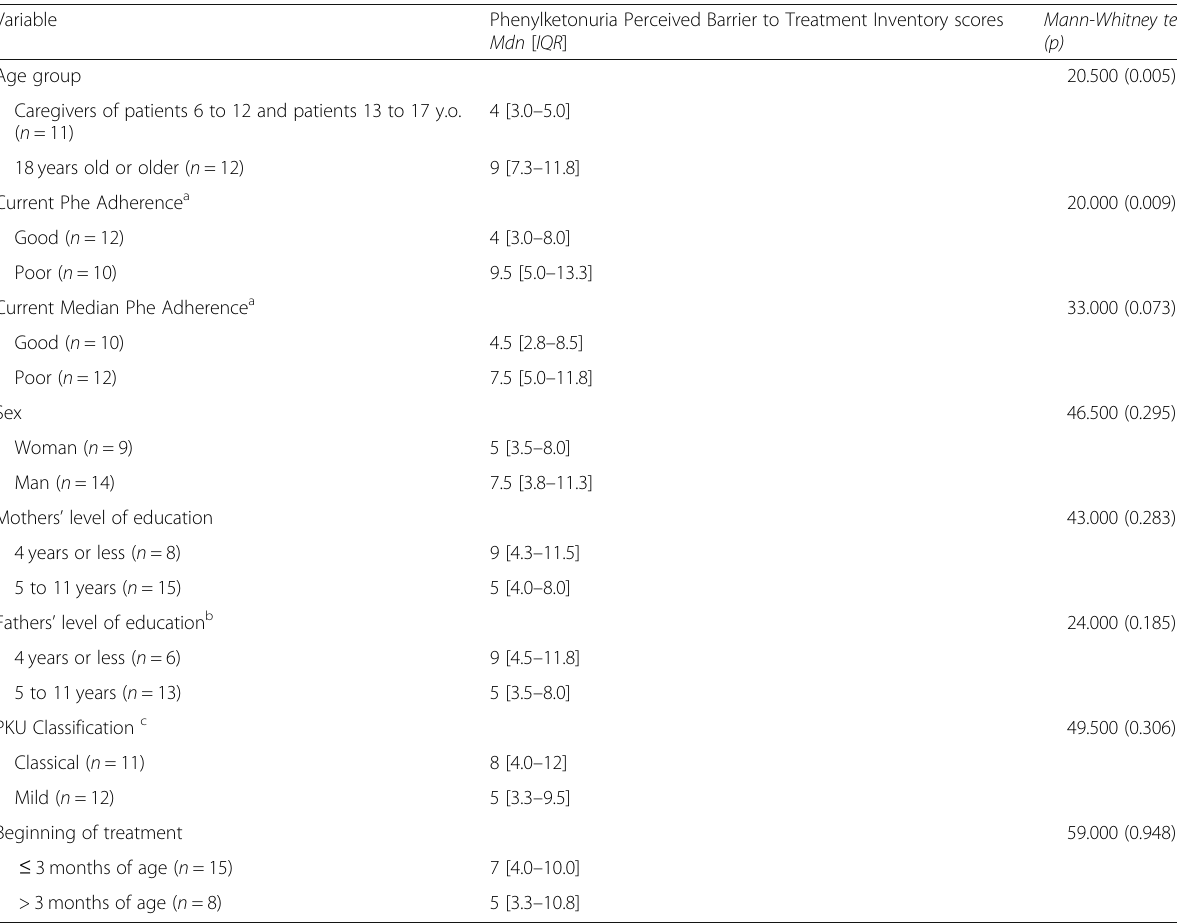
Table 5 Differences Phenylketonuria Perceived Barrier to Treatment Inventory scores between patients ’ demographic